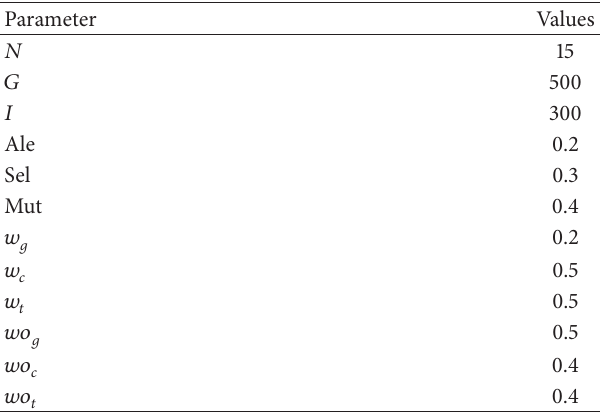
Table 12: TriGen algorithm control parameters for Human GDS4472 Dataset.